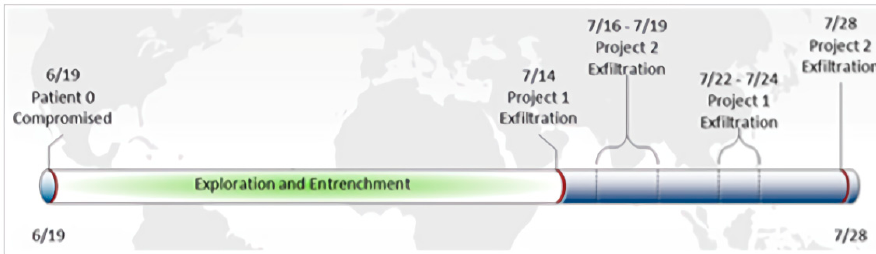
Figure 4. Data exfiltration timeline.